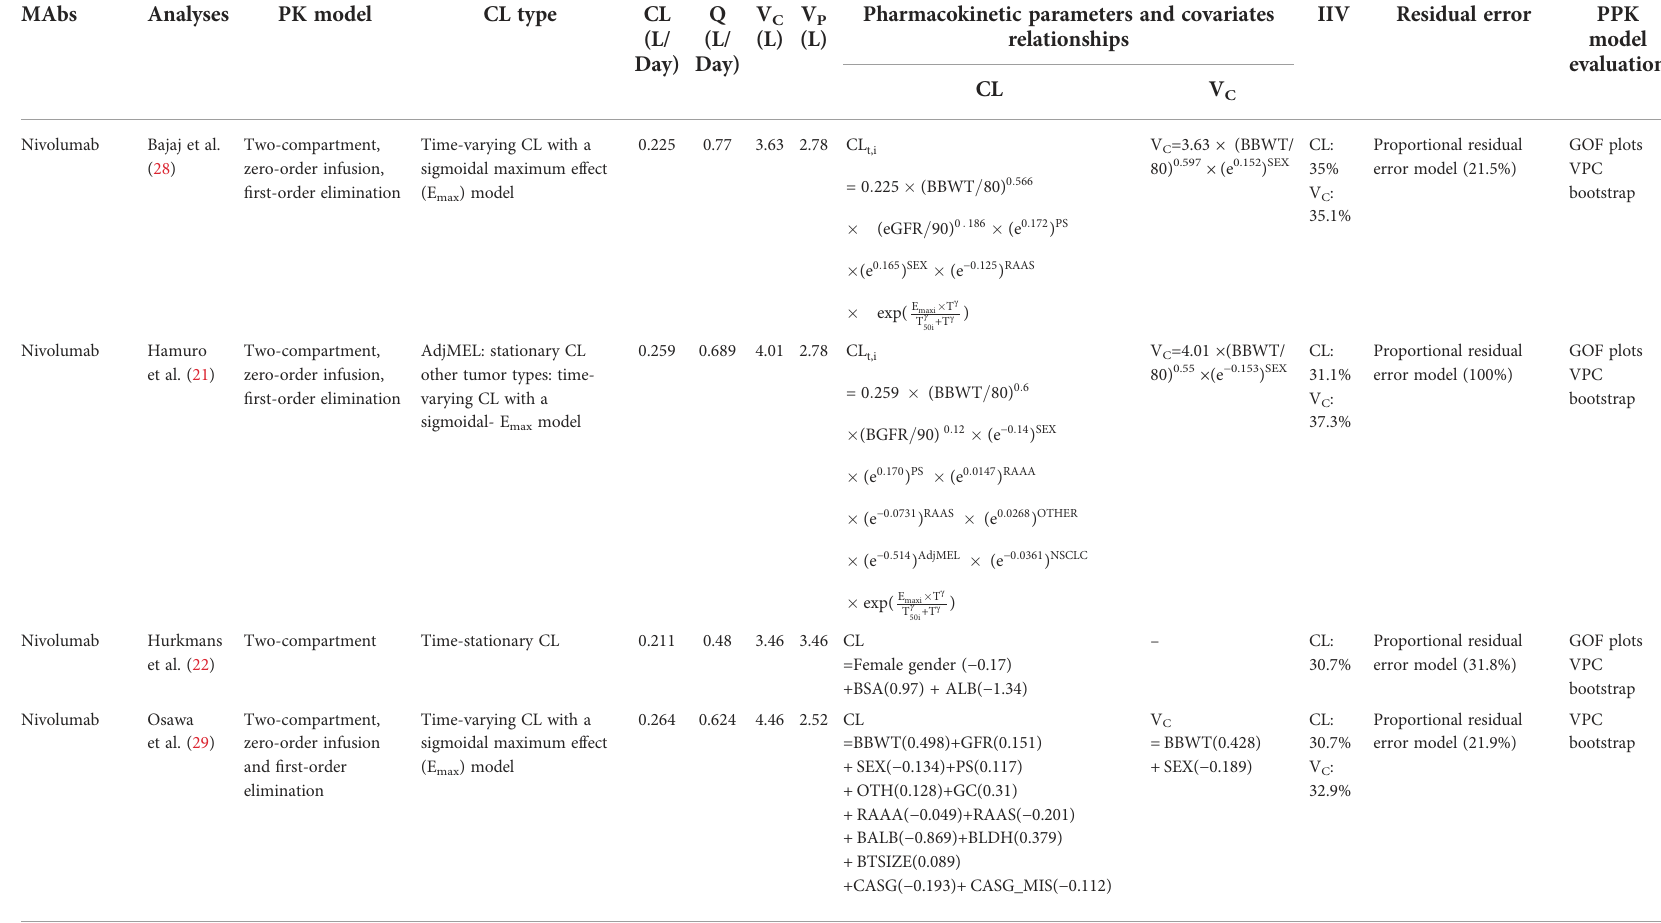
TABLE 3 Modeling strategies and PK parameters of published PPK analyses of anti-PD-1 mAbs.